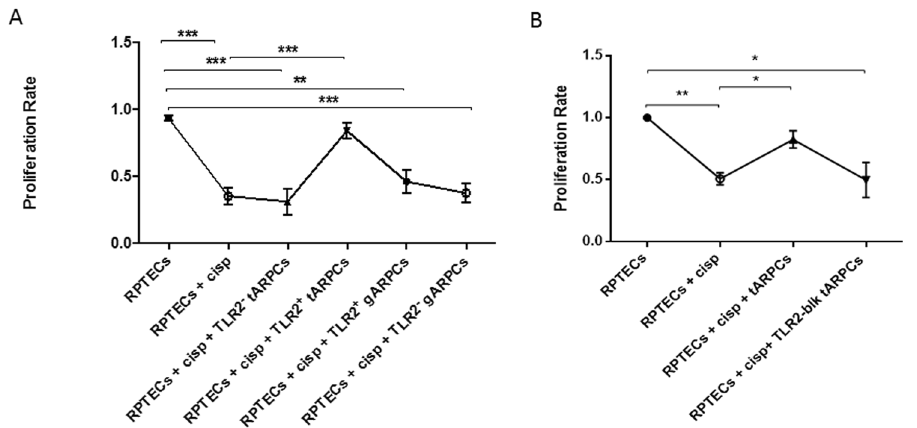
Figure 4. The repair induced by tARPCs was mediated by the Toll-like receptor-2. ( A ) BrdU cell proliferation assays showed that TLR2 + tARPCs were able to induce the repair of cisplatin damaged RPTECs in the co- culture system. On the contrary, the TLR2 − tARPCs and the TLR2 + gARPCs did not change the proliferation rate of damaged cells. ( B ) Cisplatin damaged RPTECs showed a limited proliferation rate in co-culture with tARPCs when TLR2 on renal progenitors was neutralized by a specific TLR2 blocking antibody. Plots represent 5 independent experiments using ARPCs from 5 different subjects; ** P < 0.005, *** P <